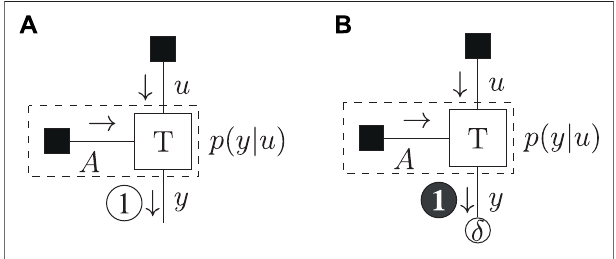
FIGURE 2 | Message passing schedule for the example model of (Eq. 37 ) for the BFE (A) and CBFE (B) . The dashed box summarizes the observation model.